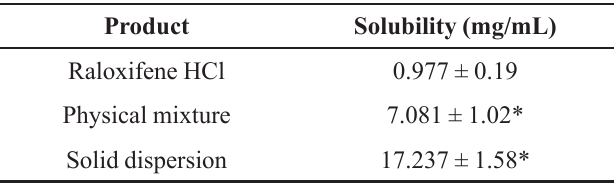
TABLE II - Solubility study of Raloxifene HCl, physical mixture and solid dispersion